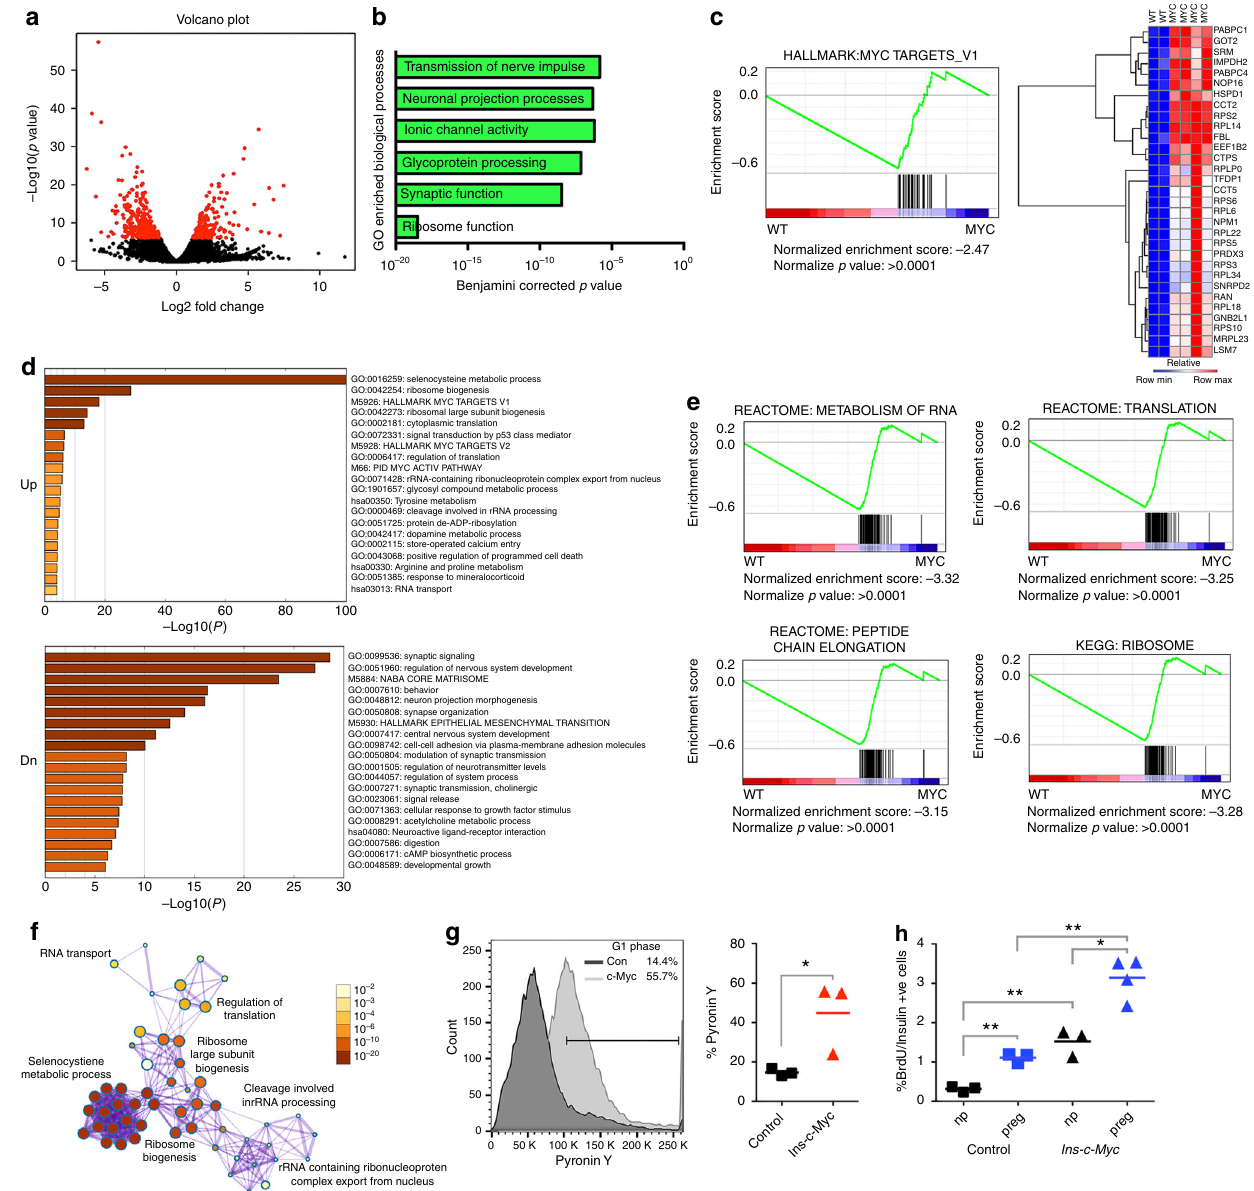
Fig. 5 Global changes in β cells with stabilized c-Myc lead to an immature phenotype. a Volcano plot of transgenic ( Ins-c-Myc ) islets as compared to controls, with genes that are signi fi cantly ( p value < 1e − 06) changed marked in red. b Gene ontology analysis shows signi fi cant changes in cell growth processes, with the most signi fi cant change in “ Ribosome Function ” in transgenic islets. c Hallmark c-Myc targets that were highly signi fi cantly enriched in the transgenic samples identi fi ed using gene set enrichment analysis (GSEA). d Pathways differentially upregulated or downregulated in transgenic islets as compared to controls. e GSEA analysis of differentially expressed genes shows enrichment of genes involved in RNA and protein synthesis in the transgenic (myc) samples as compared to the controls (WT). f Metascape analysis shows signi fi cant overlap between RNA and protein synthesis pathways in the transgenic islet samples. Color-coding denotes p values. g Pyronin Y staining of islets isolated from Ins-c-Myc and control animals. n = 3 per group. * p < 0.05, Student ’ s t test. h BrdU incorporation was quanti fi ed in control (squares) and Ins-c-Myc (triangles) animals at 3 months of age either not pregnant (black) or at 14.5 days of gestation (blue). n = 3 per group. * p < 0.05, ** p < 0.005, Student ’ s t RNA metabolism ( Pabpc1 , Pabpc4 ), mitochondrial function ( Got2 , Hspd1 , Prdx3 ), biosynthetic reactions ( Srm , Impdh2 , Ctps , Tfdp1 , Ran , Gnb2l1 ), protein folding ( Cct2 , Cct5 ), and ribosome among biogenesis and function ( Nop16 , Rps2 , Rpl14 , Fbl , Eef1b2 , Rplp0 , Rps6 , Rpl6 , Npm1 , Rpl22 , Rps5 , Rps3 , Rpl34 , Snrpd2 , Rpl18 , Rps10 , and “ Neuron projection morphogenesis ” Mrpl23 ). (GO:0048812), among others, were signi fi cantly downregulated (Fig. 5d). Thus, pathways encompassing genes involved in RNA and protein metabolism, and processes critical for cell replication were signi fi cantly enriched in transgenic islets (Fig. 5e, f). These